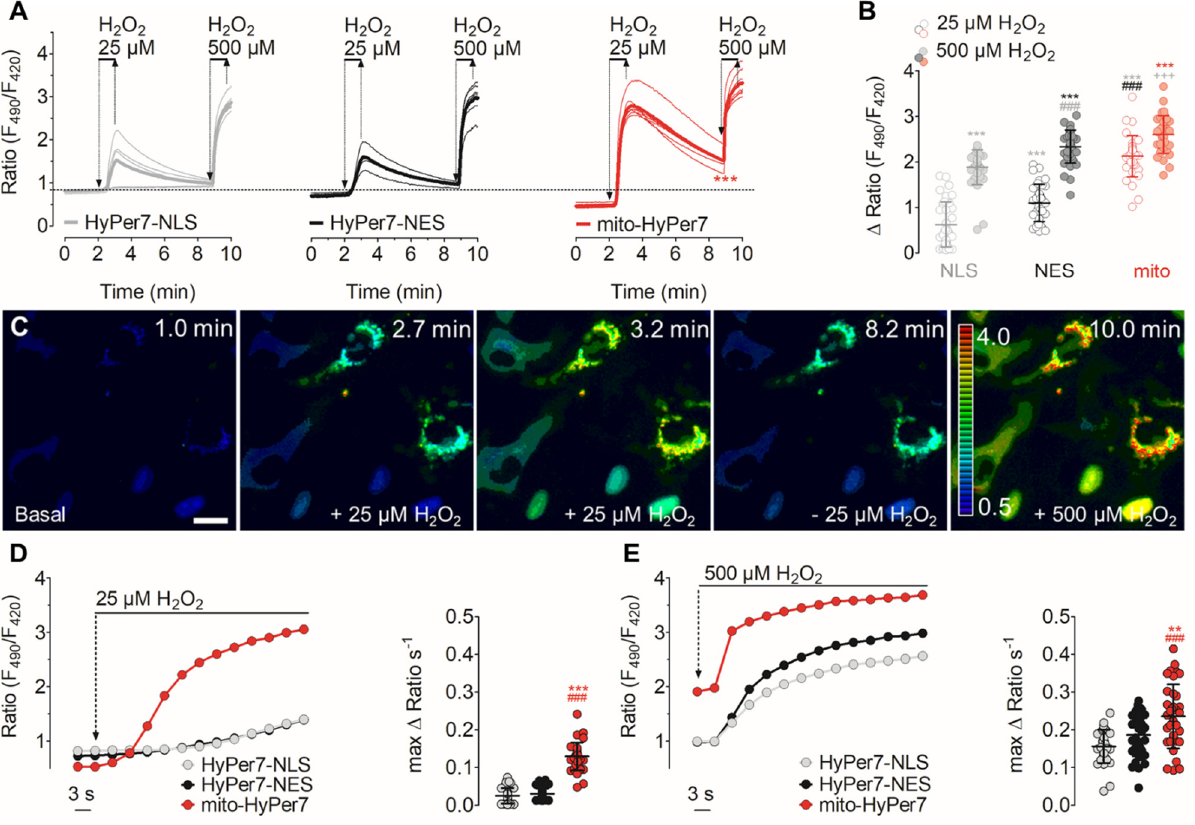
Figure 3. Multiparametric live-cell imaging of H 2 O 2 in co-cultured cell lines. ( A ) Real-time traces of HyPer7 signals ((nuclear-targeted (grey curves, n = 6), cytosolic-targeted (black curves, n = 6), and mitochondria-targeted (red curves, n = 7)) in response to administration and withdrawal of 25 µM and 500 µM exogenous H 2 O 2 . All experiments are derived from a single field of view. ( B ) Scatter dot plot shows statistical analysis from panel A; maximum HyPer7 ratio amplitudes in response to 25 µM (nuclear-targeted HyPer7, clear white dots, n= 5/36; cytosolic-targeted HyPer7, clear grey dots, n = 5/38; mitochondria-targeted HyPer7, clear red dots, n = 5/35) and 500 µM (nuclear-targeted HyPer7, full light grey dots, n= 5/36; cytosolic-targeted HyPer7, full dark grey dots, n = 5/38; mitochondria-targeted HyPer7, full red dots, n = 5/35). ( C ) Representative widefield ratio images (generated by dividing F 490 images by F 420 images) under basal conditions (very left image) in response to 25 µM H 2 O 2 at different times points as indicated (second and third image), upon withdrawal of 25 µM H 2 O 2 (fourth image) and in response to 500 µM H 2 O 2 (right image). ( D , E ) Left panels show the overlay of real-time traces of HyPer7 signals in response to 25 µM (panel D) or 500 µM H 2 O 2 (panel E) (nuclear HyPer7, grey curve; cytosolic HyPer7, black curve; mitochondrial HyPer7, red curve). Right panels show scatter dot plots and statistical analysis of the maximum ΔRatio per second of HyPer7 in the respective cellular locale (nucleus, grey dots, (n = 5/36); cytosol, black dots, (n = 5/38), and mitochondria, red dots, n = 5/35). One-way ANOVA and Bonferroni’s multiple comparison post-test were applied to compare all columns with each other. p < 0.0001 p -value summary (25 µM: Cyto vs. mito ***, Mito vs. Nuc ###, Cyto vs. Nuc n.s.); (500 µM: Cyto vs. mito **, Mito vs. Nuc ###, Cyto vs. Nuc n.s.). All values are given as ±SD.